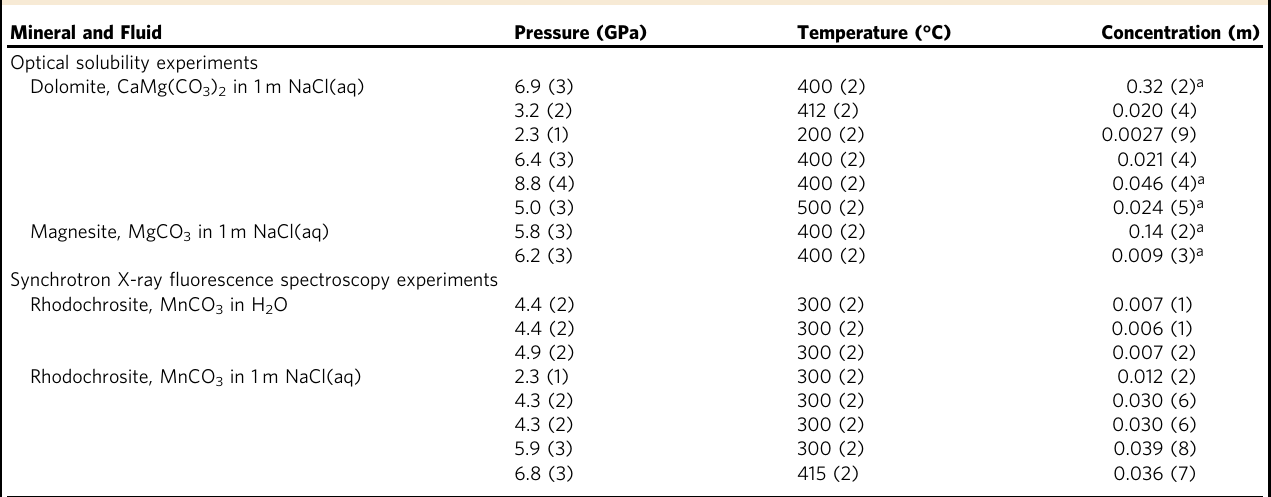
Table 1 Carbonate solubility